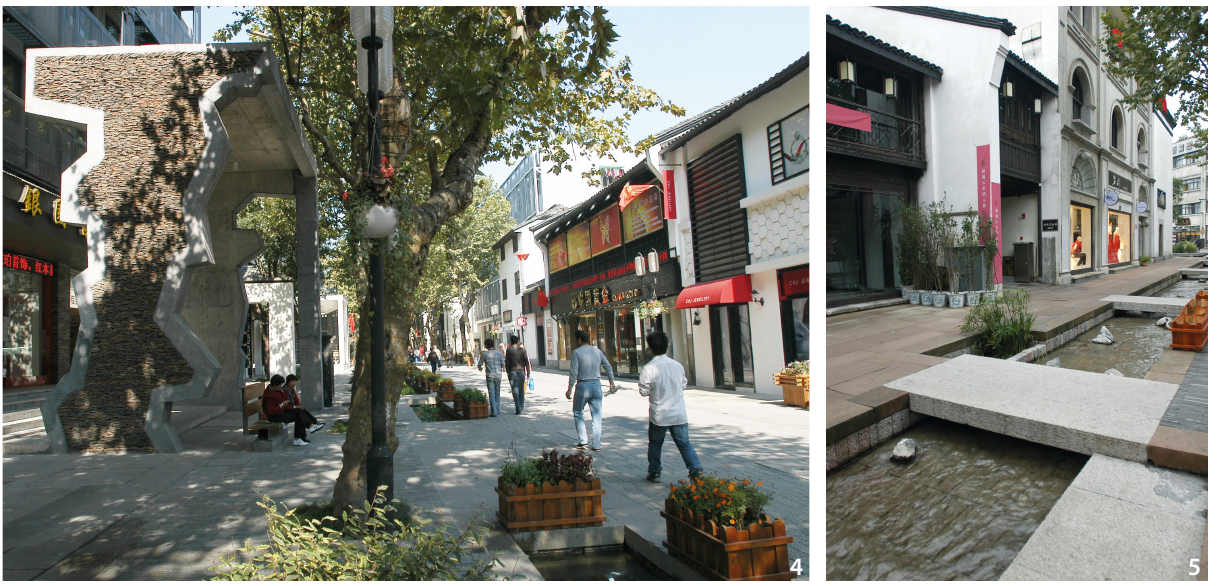
Figure 4 Small buildings along the street after completion (Source: the author). Figure 5 Reconstruction of the water network (Source: the author).